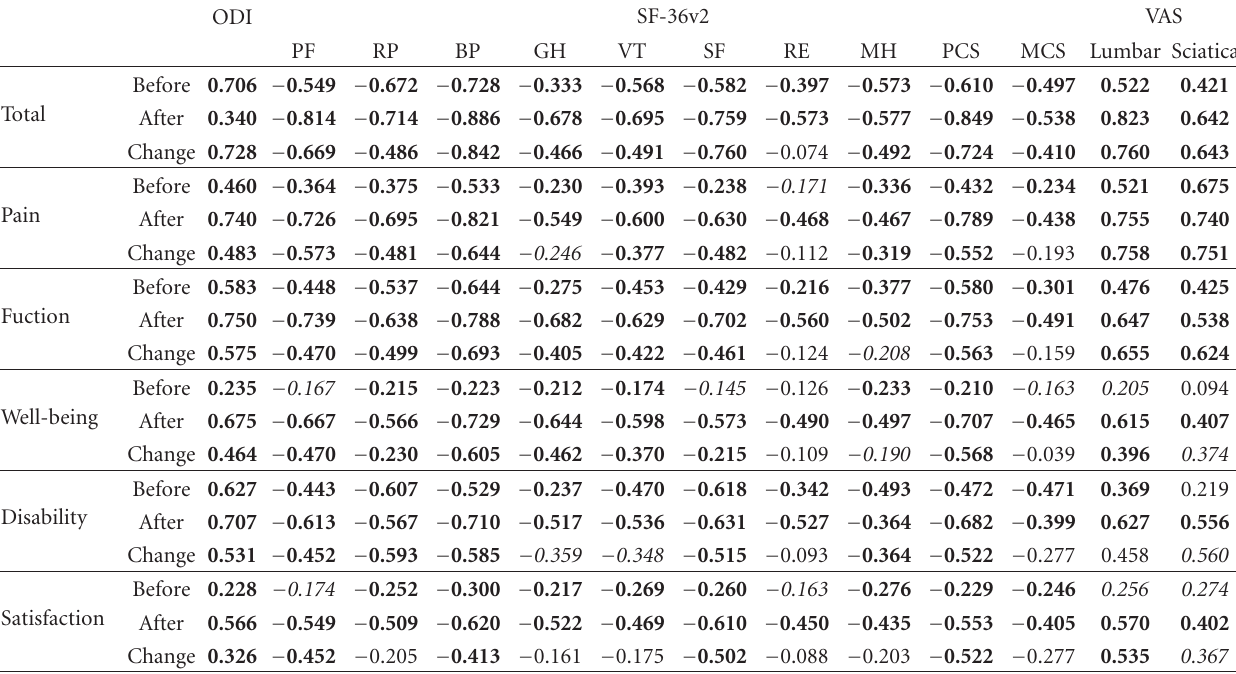
Table 4: Pearson’s correlation coe ffi